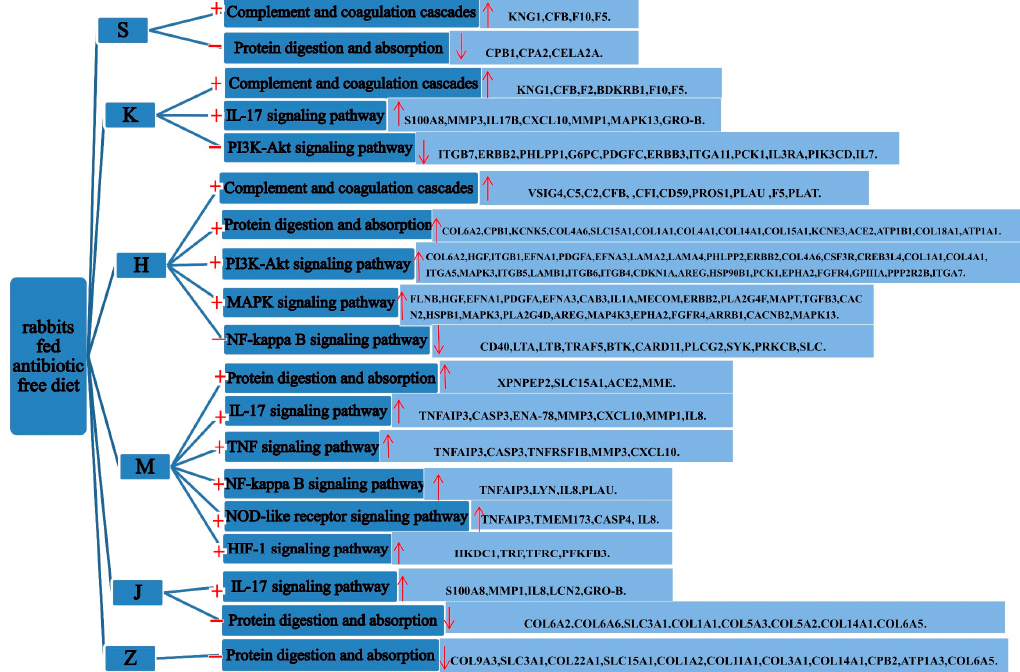
Figure 6. The significantly enriched pathways in DEGs from different intestinal segment comparison groups. S: